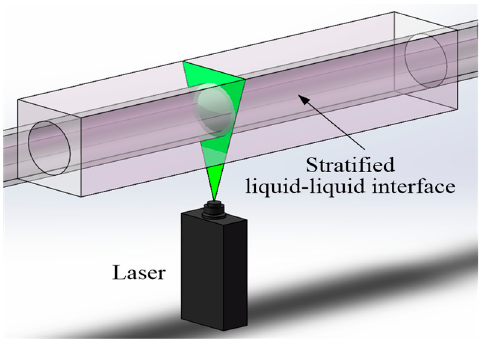
Figure 6. Sketch of the planar laser-induced fluorescence (PLIF) system for the visualization of the static liquid-liquid interface.